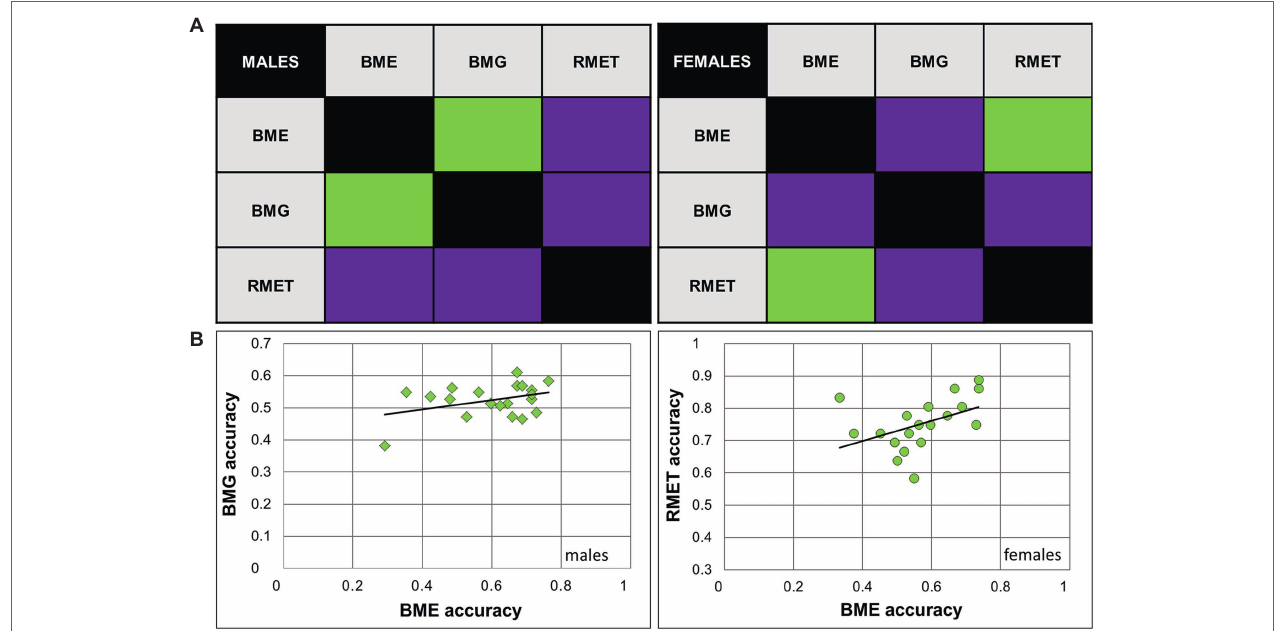
FIGURE 2 | Relationship between accuracy of emotion and gender recognition through biological motion, and performance on the Reading Mind in the Eyes Test for female and male observers. (A) Correlation matrices between accuracy of performance (correct response rate) on emotion (BME) and gender (BMG) recognition through biological motion (BM), and the Reading Mind in the Eyes Test (RMET). Significant correlations (Pearson product-moment correlation; p < 0.05) are color- coded by green, non-significant correlation by violet. (B) Correlations between BMG and BME accuracy in males (left panel, diamonds), and between the RMET and BME accuracy in females (right panel, circles) were